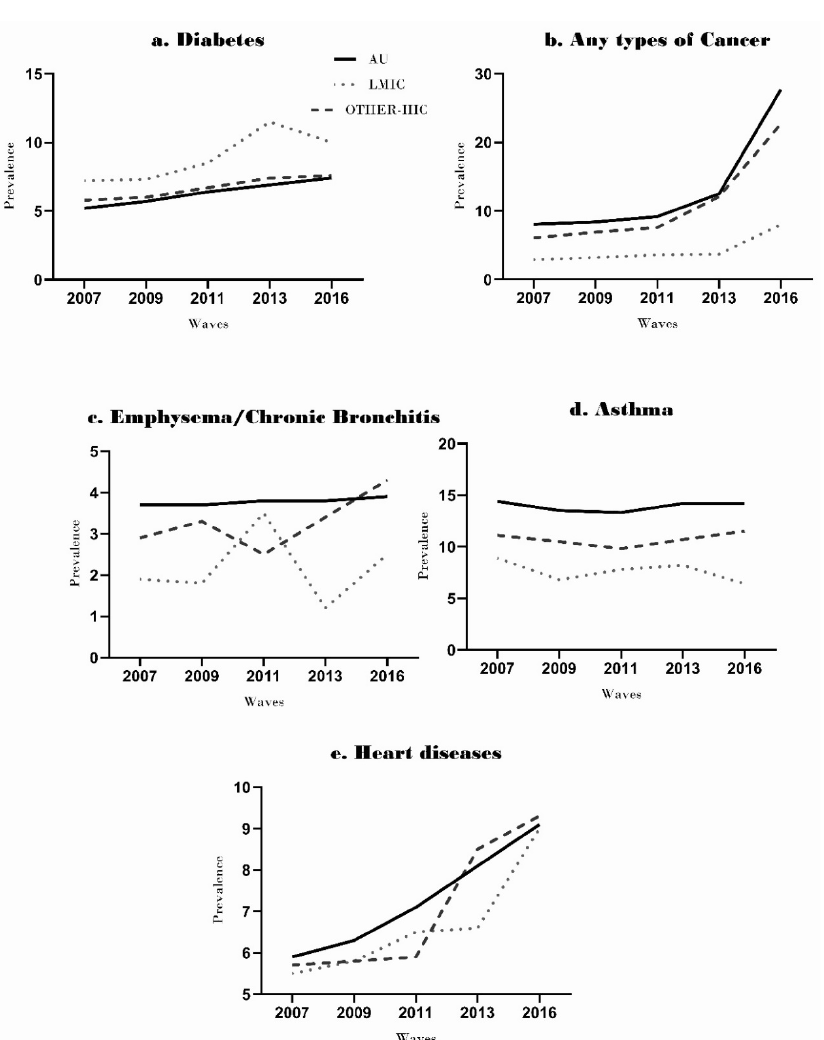
Figure 1. Prevalence of chronic diseases of immigrants (High-income countries and Low–middle-income countries) and Australian born people across five waves: 2007–2016 ( a ) prevalence of diabetes across five waves ( b ) prevalence of cancer across five waves ( c ) prevalence of emphysema/chronic bronchitis across five waves ( d ) prevalence of asthma across five waves ( e ) prevalence of heart diseases across five waves.